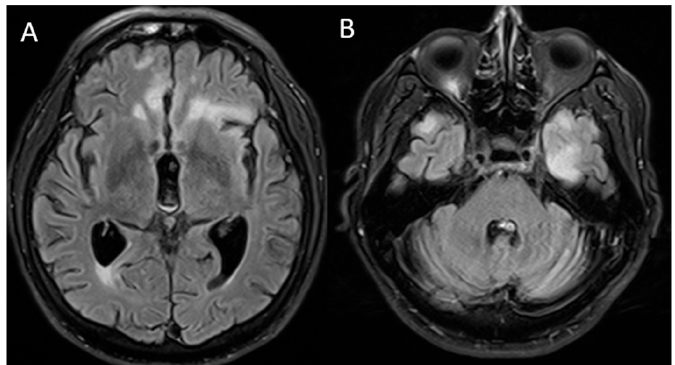
Figure 2. Brain magnetic resonance imaging: T2/FLAIR sequence finding ( A ) lower-volume lesions in the bilateral frontal lobes compared to that in the previous MRI and ( B ) new hyperintense lesions, predominantly in the left temporal region.